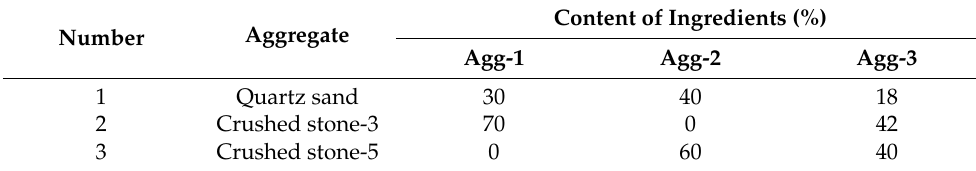
6 of 18 Table 5. Selected aggregate ratios. Number